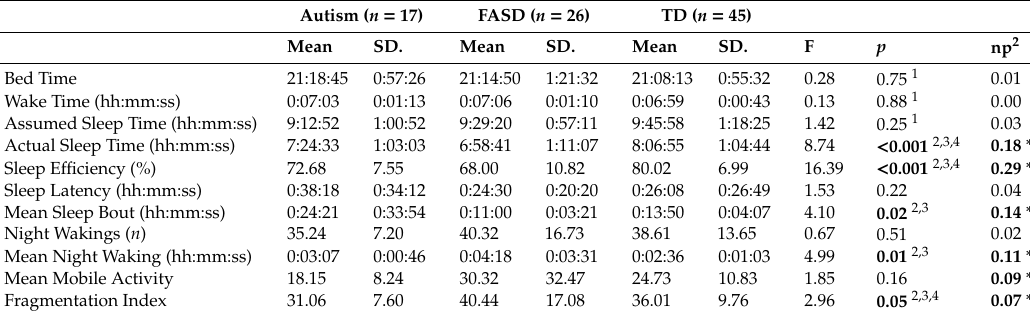
Table 2. Group di ff erences for actigraphy.